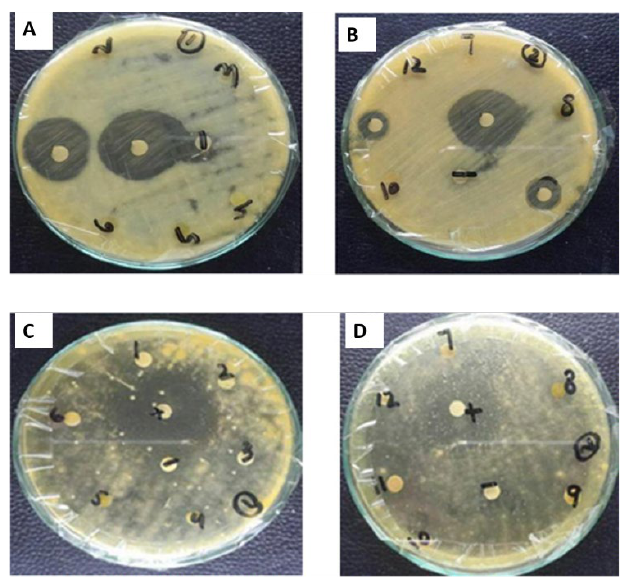
The sample concentration was 100 µg per disc. Values (mean ± SD) are the average triplicate anal- ysis of each plant extract (n value of 1 × 3). - = No activity. Samples showing zona e of inhibition ≥12 mm are not appli cable for MIC determination. S.A = Staphylococcus aureus , B.S = Bacillus sub- tilis , P.A = Pseudomonas aeruginosa , K.P = Klebsiella pneumoniae , E.C = Escherichia coli. The values with superscript (*) letters show significantly ( p < 0.05) different means.